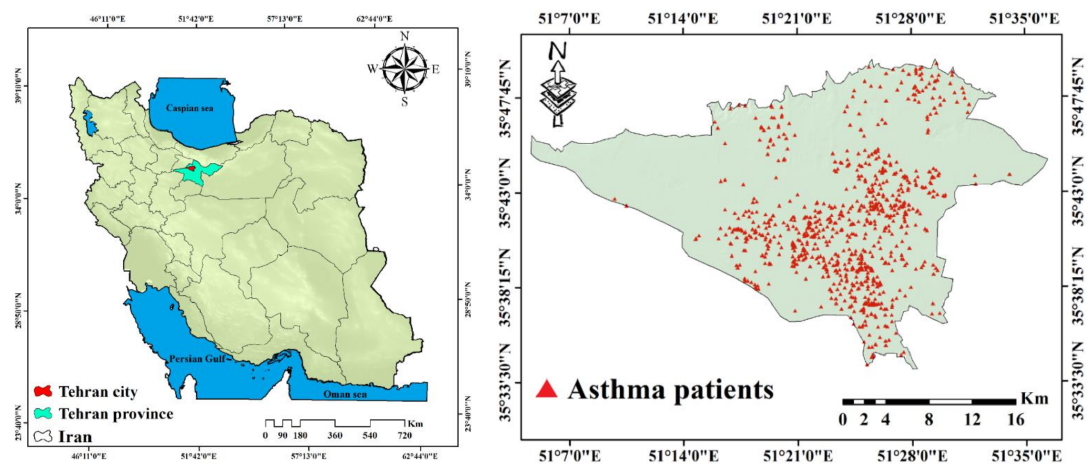
Figure 2. Study area with asthma patients’